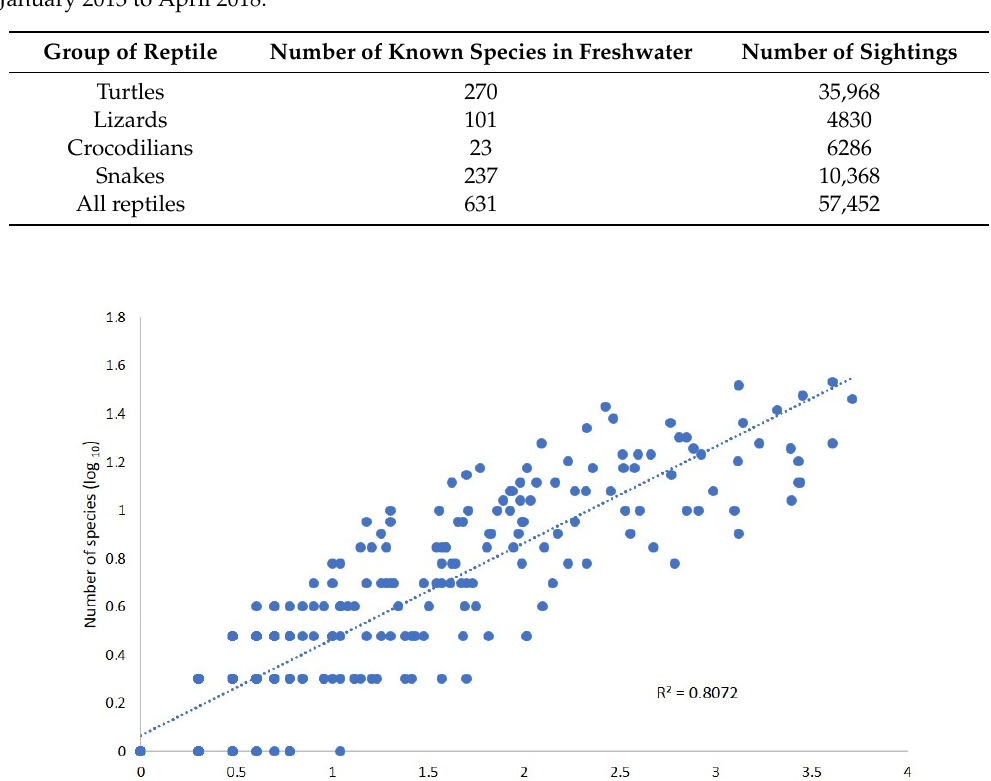
Figure 4. Number of freshwater lizard species sighted between January 2013 and April 2018 within 50 km of a city with a population of more than 100,000. All except for three species of crocodilians were sighted by human observers in the five-year period (Figure 5). Figure 5. Number of crocodilian species sighted between January 2013 and April 2018 within 50 km of a city with a population of more than 100,000. With the exception of sightings made in Eastern USA, freshwater snake sightings in cities were largely confined to the tropics and the southern hemisphere (Figure 6).